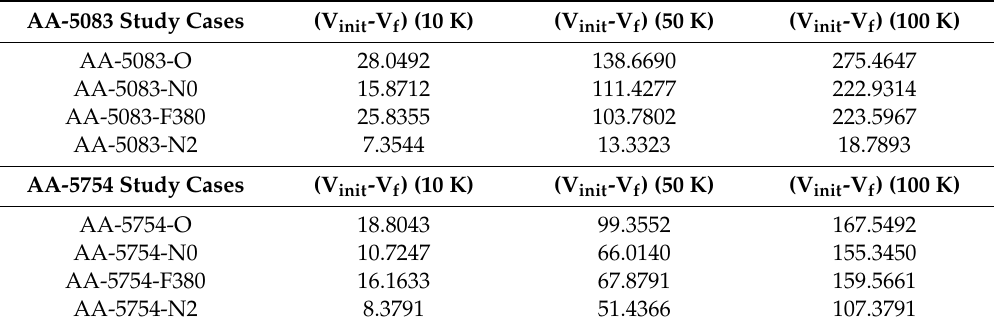
Table 1. Loss of volume (mm 3 ) for the wear tests of AA-5754 and AA-5083 at 10,000, 50,000 and 100,000